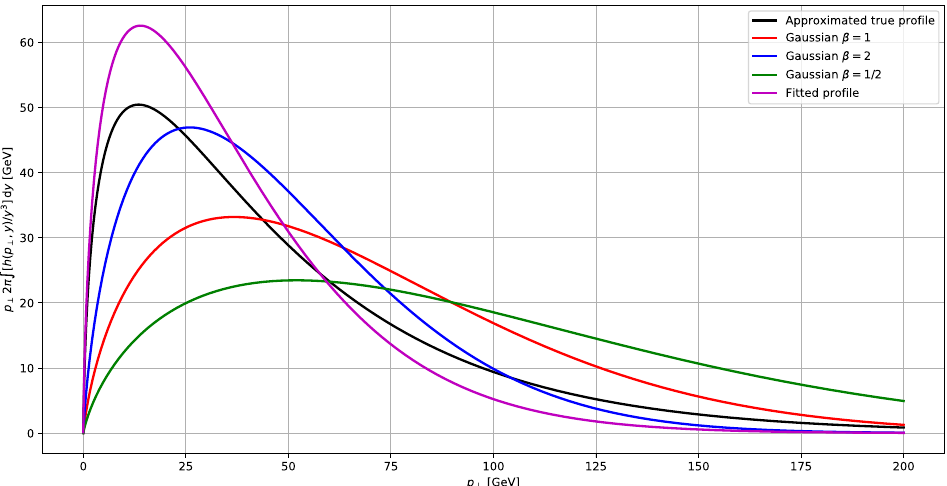
Figure 11 . Di(cid:11)erent p ? pro(cid:12)les for the subtraction term for (cid:23) = M Z . The pro(cid:12)le given by equation (3.19) which corresponds to a Gaussian distribution g ( k ? ; y ) is represented for three values of (cid:12) (red, blue and green curves). The approximated \true" pro(cid:12)le (black) and the (cid:12)tted pro(cid:12)le (magenta) are given respectively by equation (4.4) and equation (4.10). The (cid:12)tted pro(cid:12)le corresponds to a decreasing Gaussian distribution g ( k ? ; y ), as given by equation (4.9). The area under each curve is equal to (cid:23) 2 = (2 b 2 ). 0